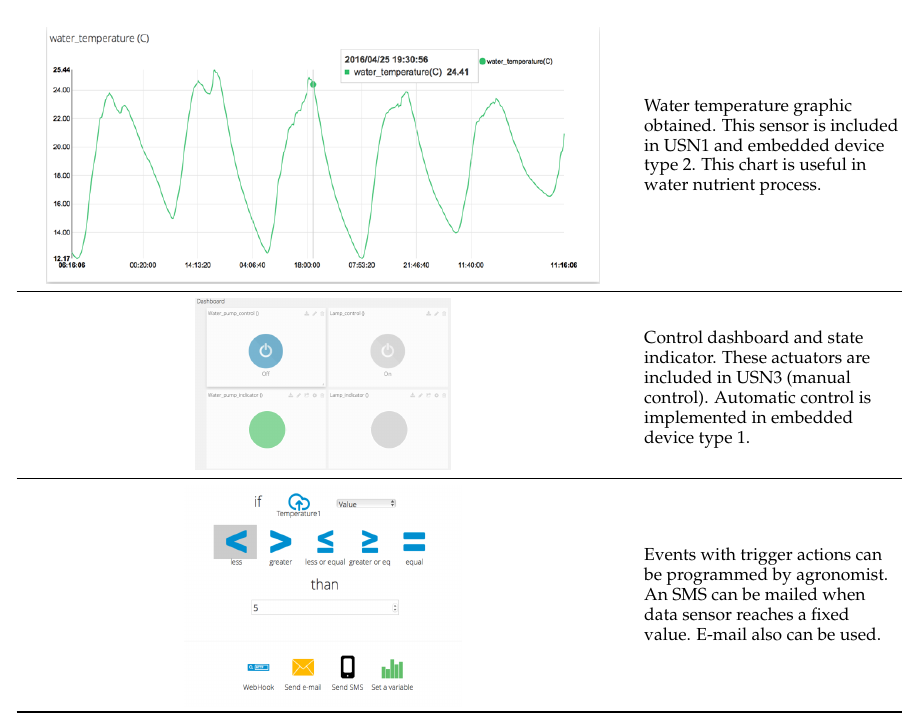
Water temperature graphic obtained. This sensor is